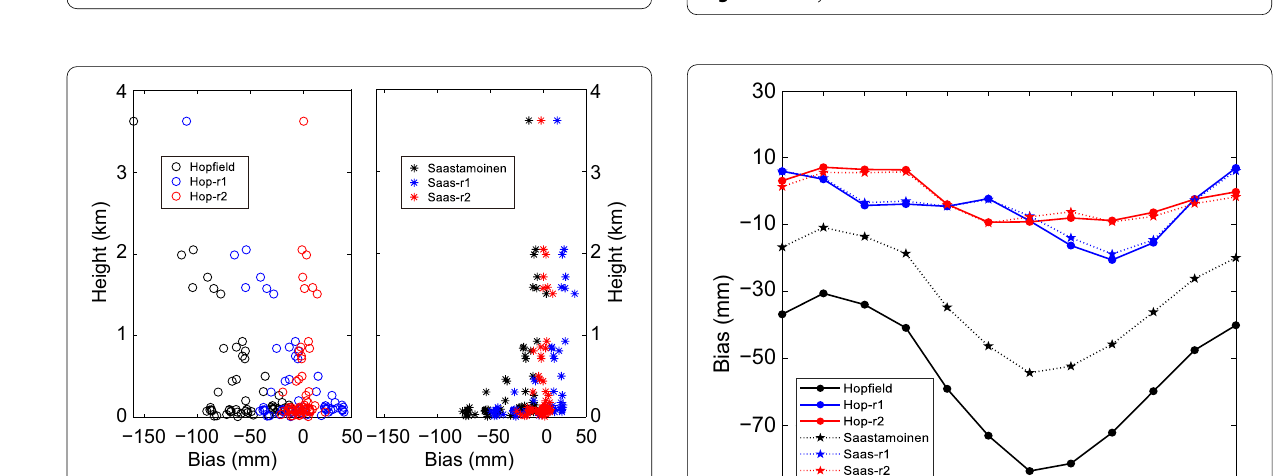
tive biases are in July which are